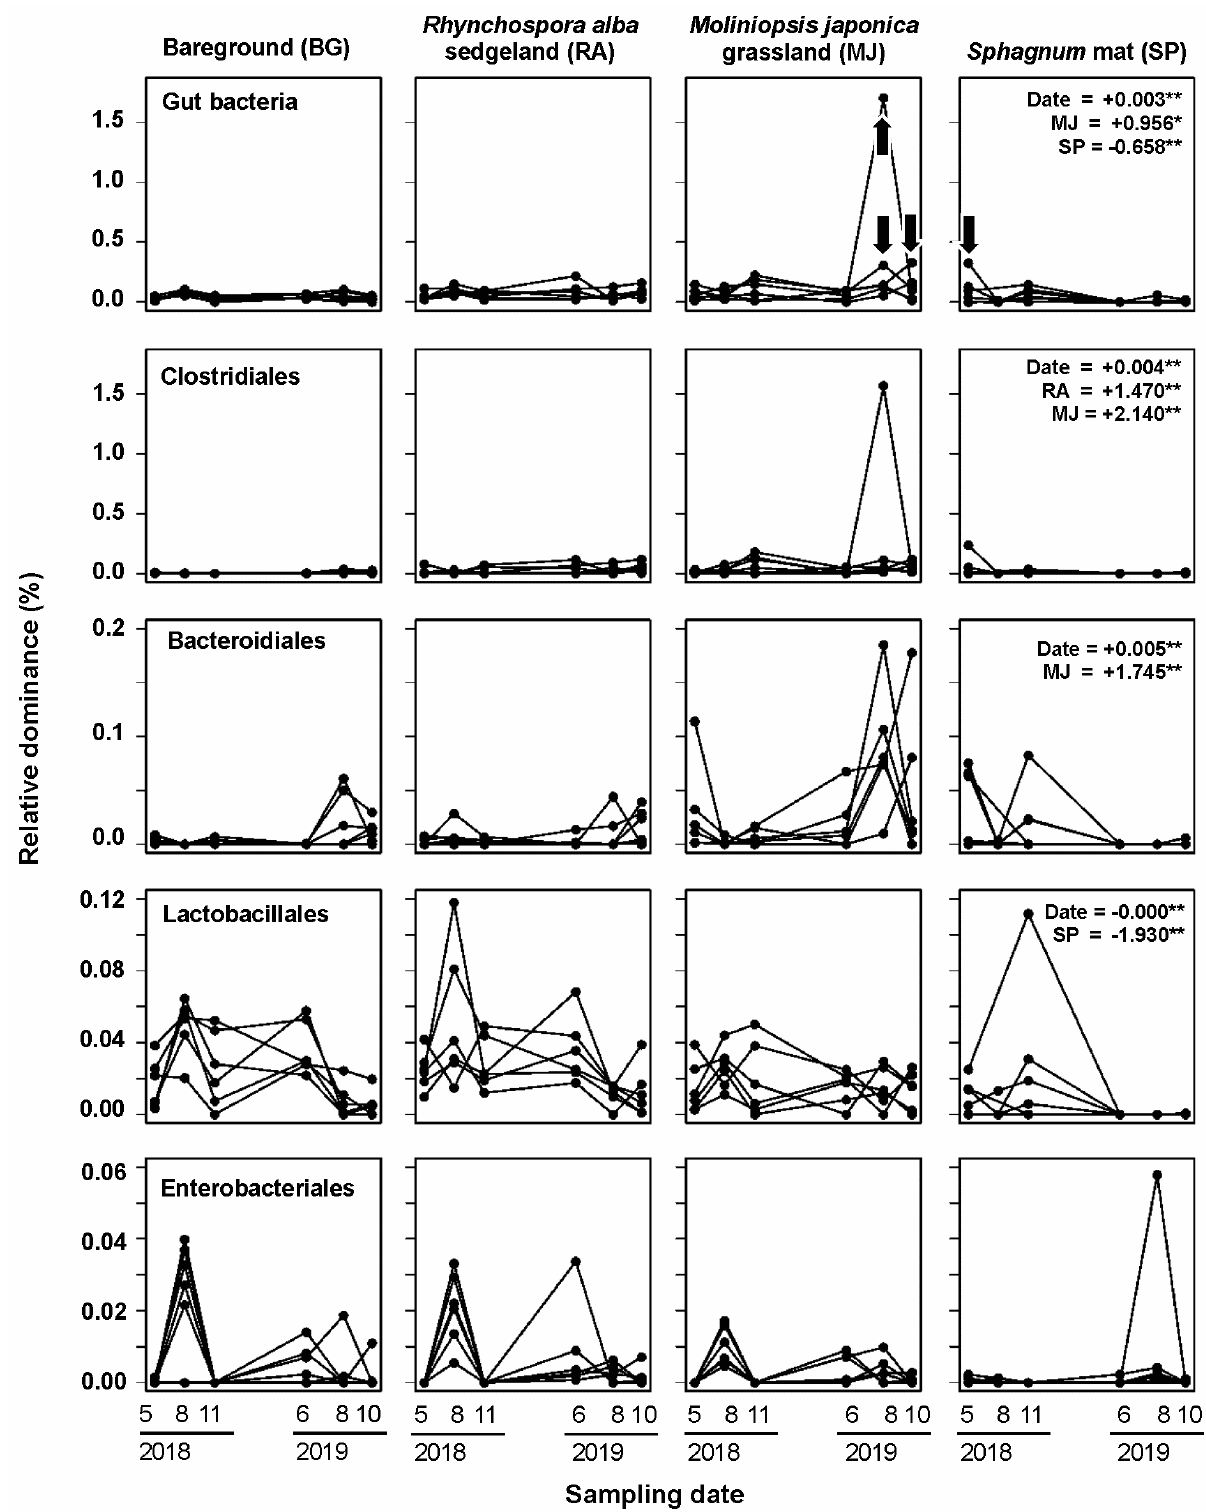
Figure 3. Seasonal fluctuations of gut-bacterium taxa estimated by OTUs in the four vegetation types during 2018 and 2019. The lines connect successive samples from the respective sampling plots. Differences in numbers of reads are examined among sampling dates and between the bareground and other three habitats by GLMM (**: p < 0.01, *: p < 0.05). The four samples that showed relatively high dominance of gut bacteria are indicated by arrows (see also Table 2). Note that the y axis scales differ between rows of